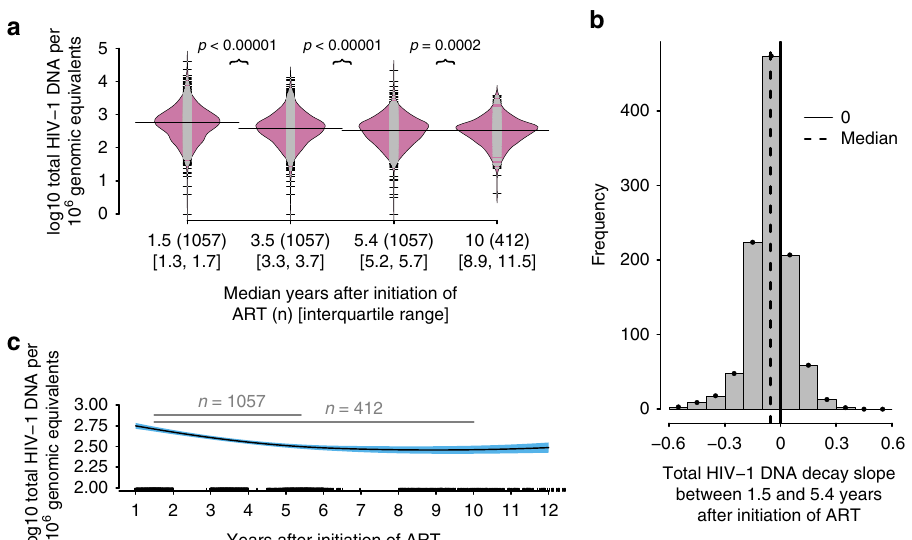
Fig. 2 The HIV-1 reservoir size and long-term dynamics in 1057 individuals on suppressive ART for on median 5.4 years. a Beanplot of total HIV-1 DNA levels in 1057 individuals on long-term suppressive ART at 3 – 4 different time points (with median 1.5, 3.5, 5.4, and 10.0 years ( n = 412) after initiation of ART) and the respective sample size. The p values were calculated using paired Wilcoxon tests. The individual observations are shown as small lines (gray or black) in a one-dimensional scatter plot. Overlaid is the estimated density of the distributions ( fi lled in pink) and the median is depicted by a black line. b Histogram of linear regression slope over the fi rst three measurements of total HIV-1 DNA levels with median 1.5 – 5.4 years after initiation of ART. c Spline fi tted to all log10 total HIV-1 DNA/1 million genomic equivalents showing the 95% con fi dence intervals in blue and sampling times after initiation of ART in years on the x -axis. Gray lines indicate median observation times for respective number of individuals; ART antiretroviral